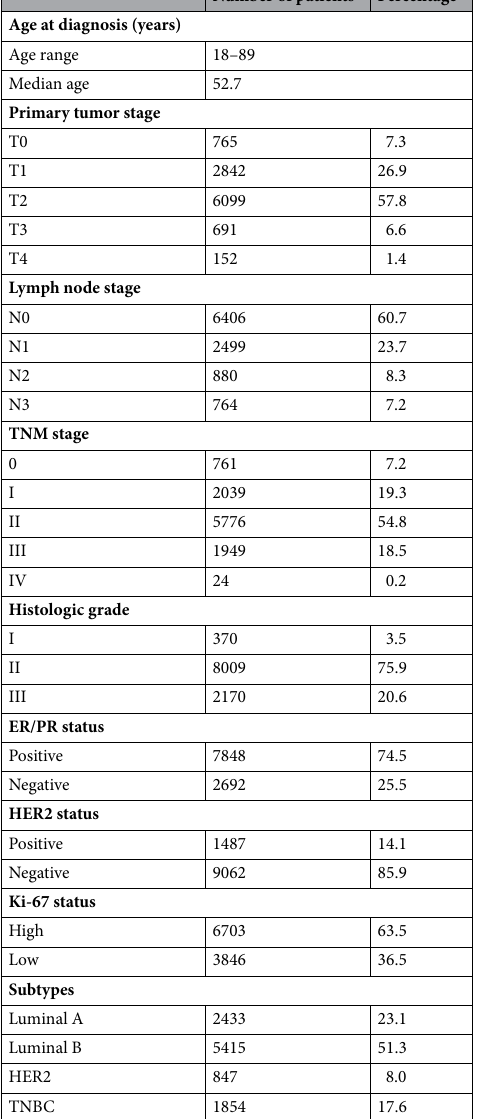
Table 1. Basic patient information.